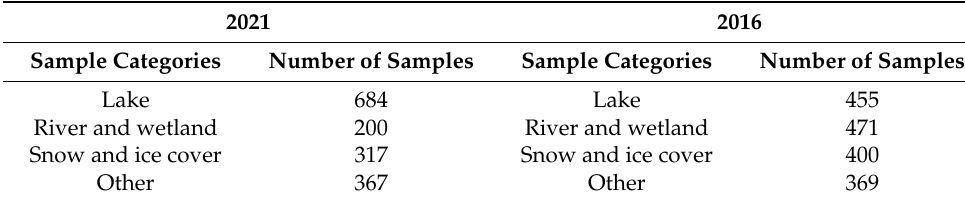
Table 1. Type and quantity of sample points on the Tibetan